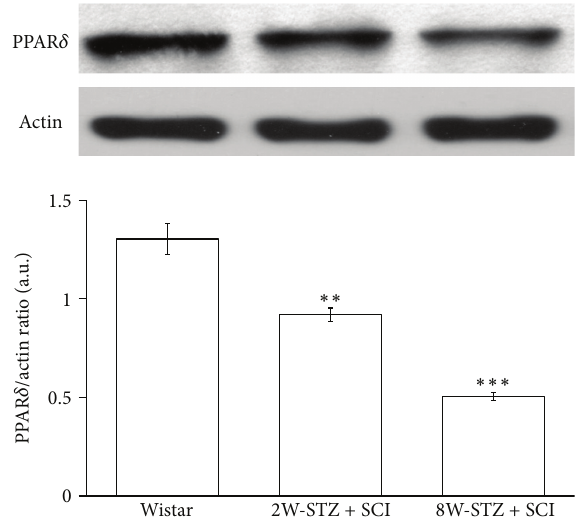
Figure 4: The expression of PPAR 𝛿 in the spinal cord obtained from normal or STZ-diabetic rats. The spinal cords of diabetic rats were obtained from the two-week induction group and the eight-week induction group. Data represent the mean ± SEM of six animals. ∗∗ 𝑃 < 0.01 and ∗∗∗ 𝑃 < 0.001 compared with the normal group.